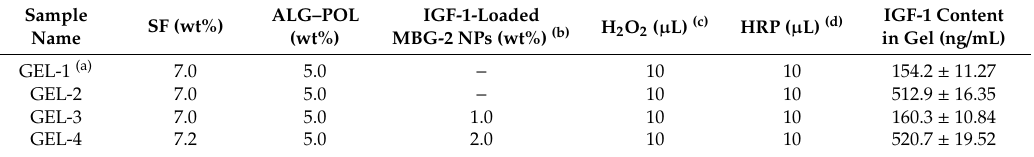
Table 4. Parameters for IGF-loaded BG / ALG–POL / SF